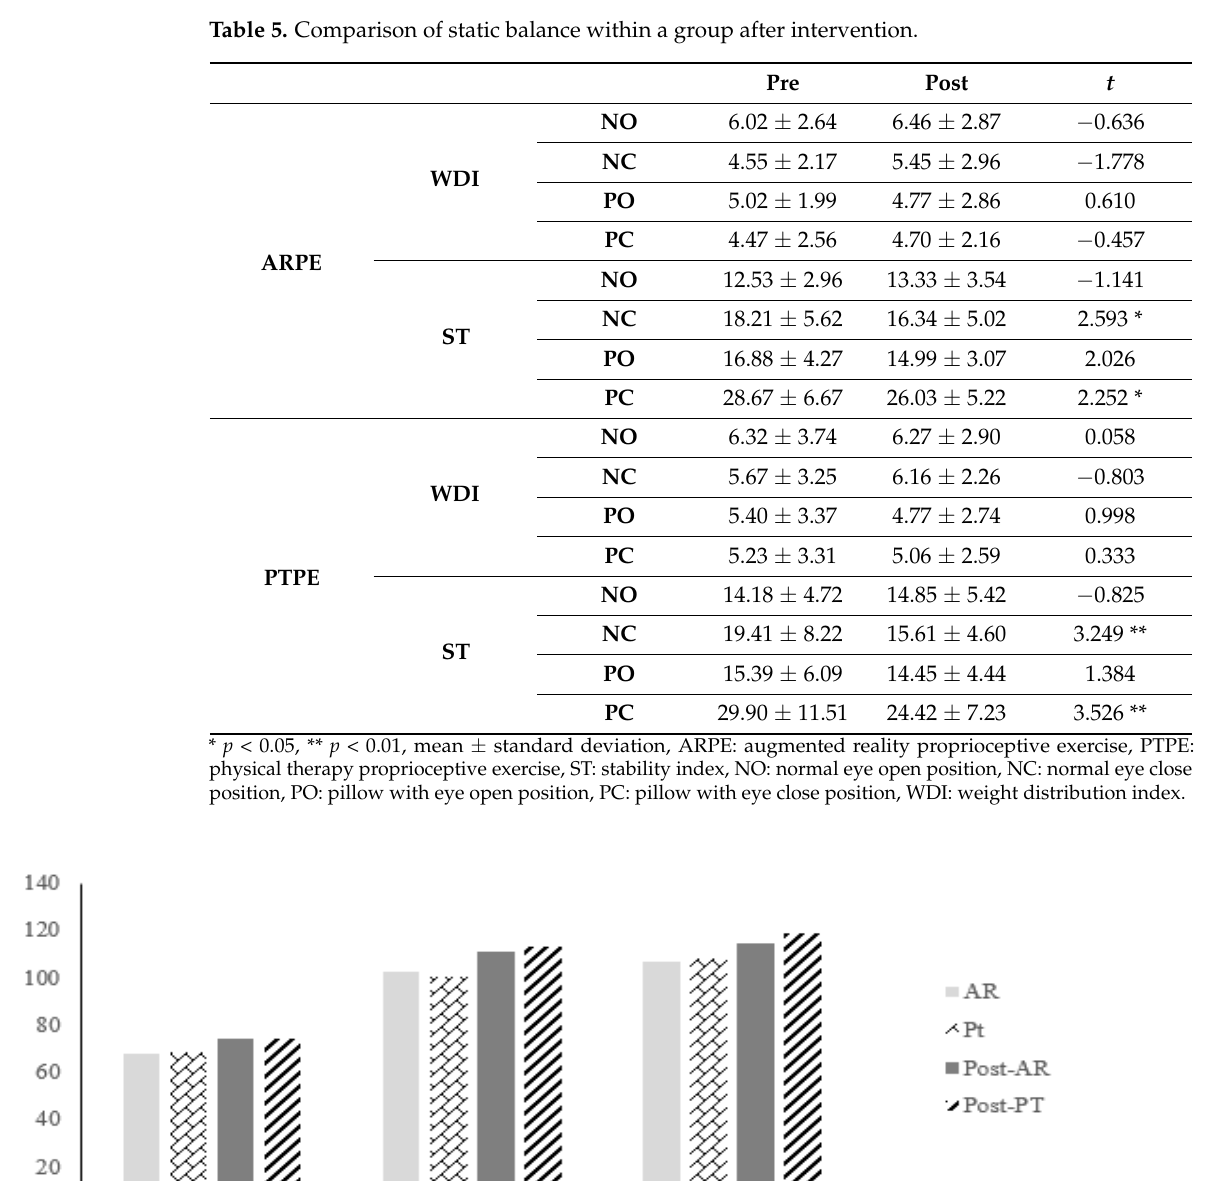
Table 5. Comparison of static balance within a group after intervention.